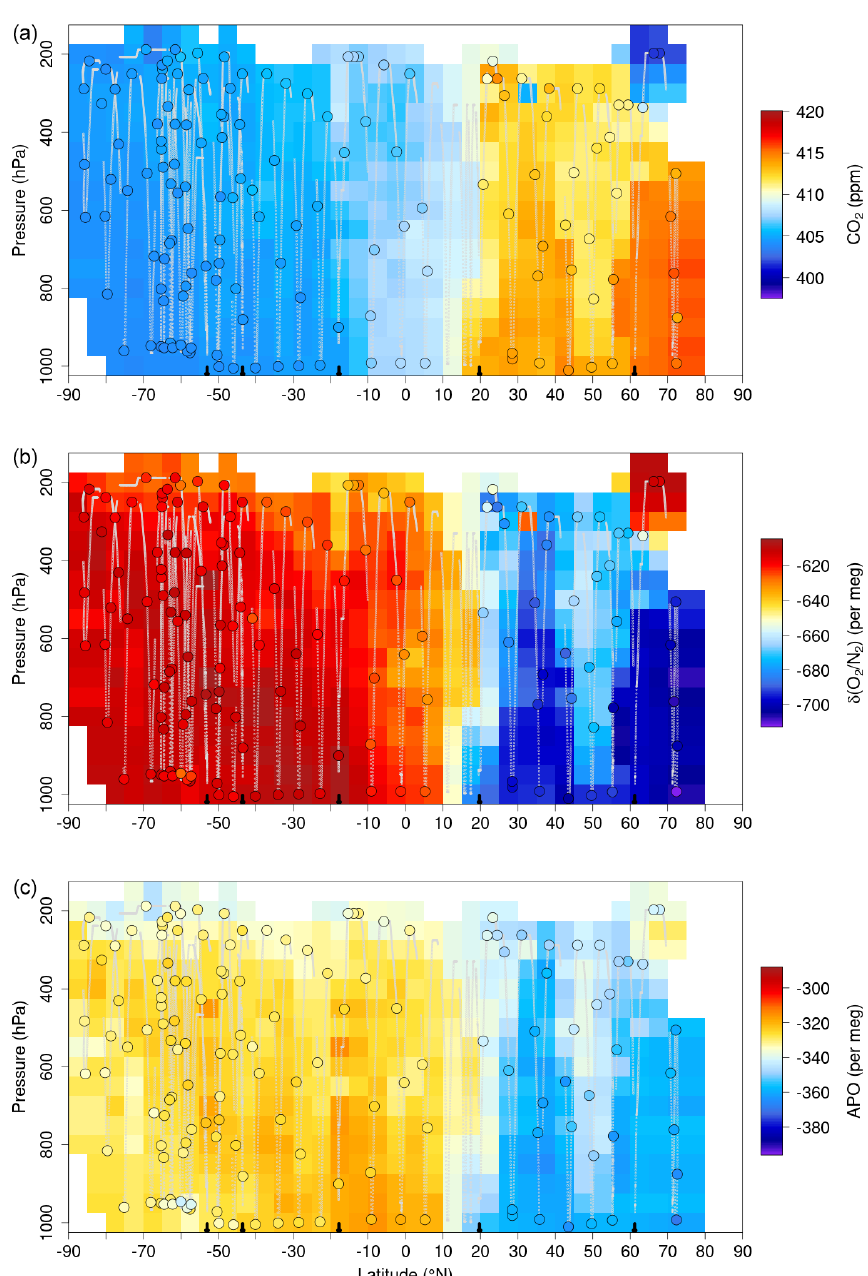
Figure 11. Altitude–latitude cross sections from the southbound Pacific transect of ATom-4 for (a) CO 2 , (b) δ (O 2 / N 2 ), and (c) APO. Flight tracks are shown as thin gray dotted lines. In situ AO2 data have been interpolated and extrapolated using bicubic spline interpolation with the akima package in R (Akima, 1978) onto a 5 ◦ latitude by 50hPa grid. Extrapolation is limited to within 4 ◦ latitude and 50hPa of the observations. Measurements on Medusa flask samples are shown as filled circles. Scales in each panel are equivalent on a molar basis. We exclude boundary layer data over land on takeoffs, landings, or missed approaches with strong terrestrial influences. Similar plots for all HIPPO, ORCAS, and ATom campaigns are presented in Figs. S13, S14, and S15 in the Supplement.